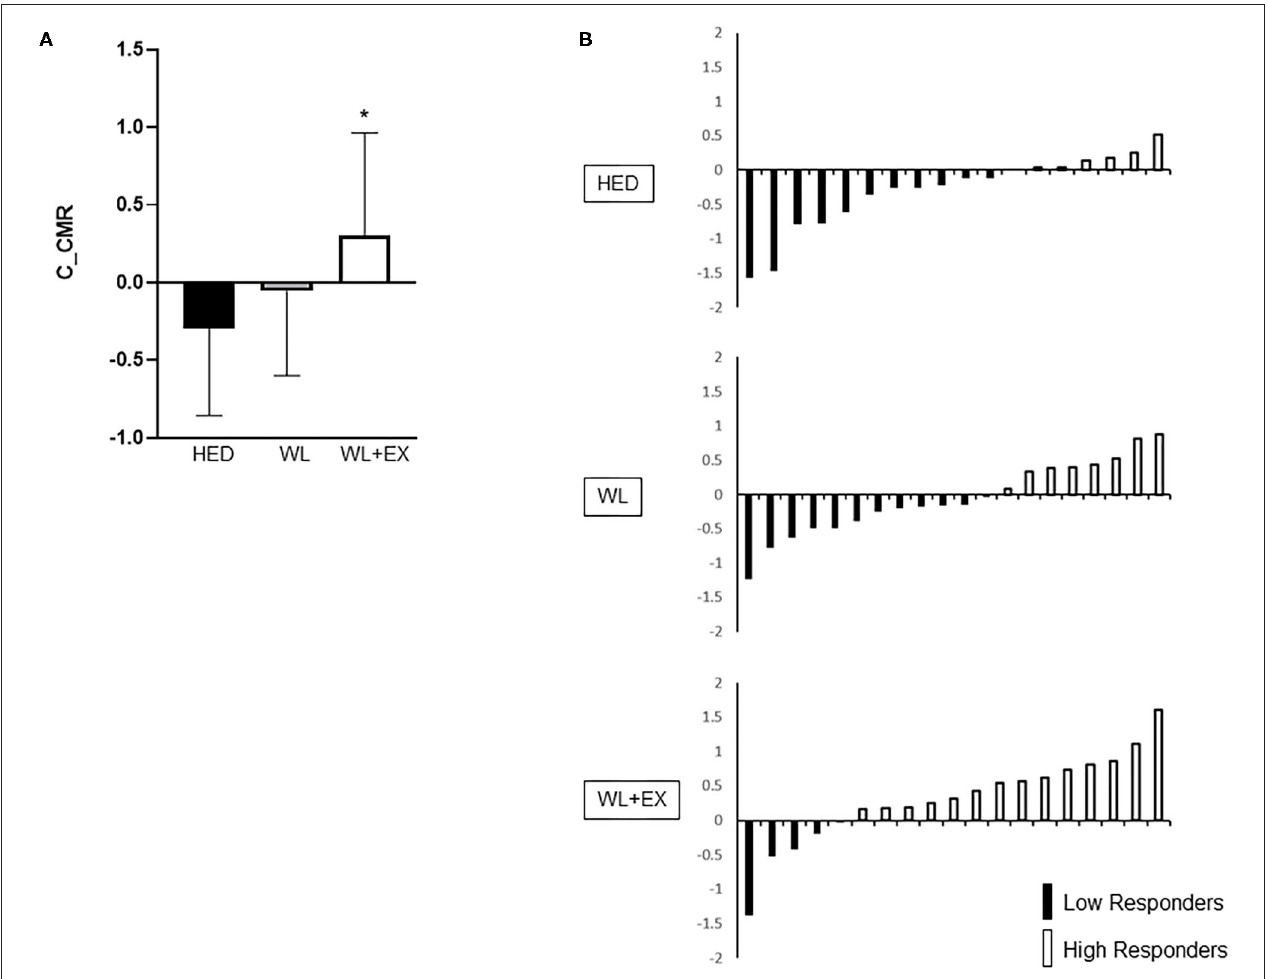
FIGURE 2 | Group differences [ (A) ; mean C_CMR and SD] and heterogeneity in individual response (B) for C_CMR. *Significantly different from HED.